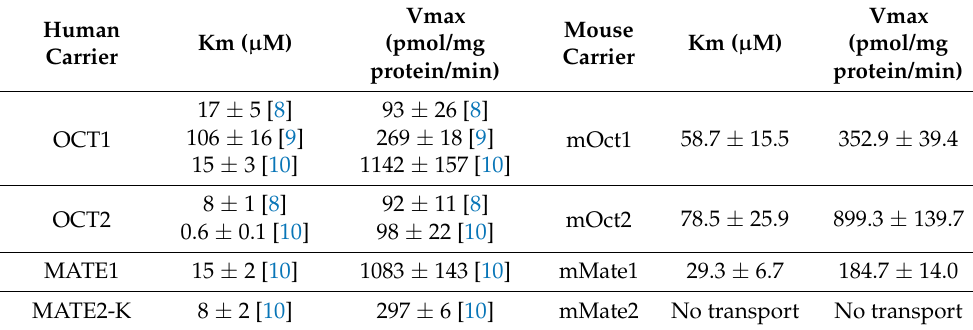
Figure 2. Trospium and MPP + uptake by mMate1 and mMate2, respectively. ( A ) Phylogenetic tree of the human and mouse MATE/Mate carriers. The following GenBank accession numbers were used: NP_060712.2 for MATE1, NP_001093116.1 for MATE2-K, NP_080459.2 for mMate1, and NP_001028714.1 for mMate2. Transport data represent means ± SD of representative experiments each with triplicate determinations. ( B ) Uptake of 1 µM trospium was analyzed in HEK293 cells stably transfected with mMate1 or mMate2 as indicated and in non-transfected control cells (neg. ctr.) over 15 min. * Significantly different from negative control with p < 0.01 (one-way ANOVA). Time-dependent uptake of ( C ) trospium via mMate1 and ( E ) MPP + via mMate2 over 1–30 min. * Significantly different from the respective time-point control with p < 0.01 (two-way ANOVA). Uptake at increasing concentrations of ( D ) trospium via mMate1 and of ( F ) MPP + via mMate2 over 1 min. Non-transfected HEK293 cells served as control (neg. ctrl.). Carrier-specific uptake is indicated by dotted lines. Michaelis–Menten kinetic parameters were calculated from carrier-specific uptakes by nonlinear regression analysis. ( G ) MPP + uptake inhibition via mMate2 at 10 µM and 100 µM inhibitor concentrations of TEA, topotecan, acyclovir, and levofloxacin, measured over 30 min. Cells not incubated with any inhibitor served as positive control (set to 100%). * Significantly different from positive control with p < 0.01 (one-way ANOVA). Table 1. Trospium transport kinetics in man and